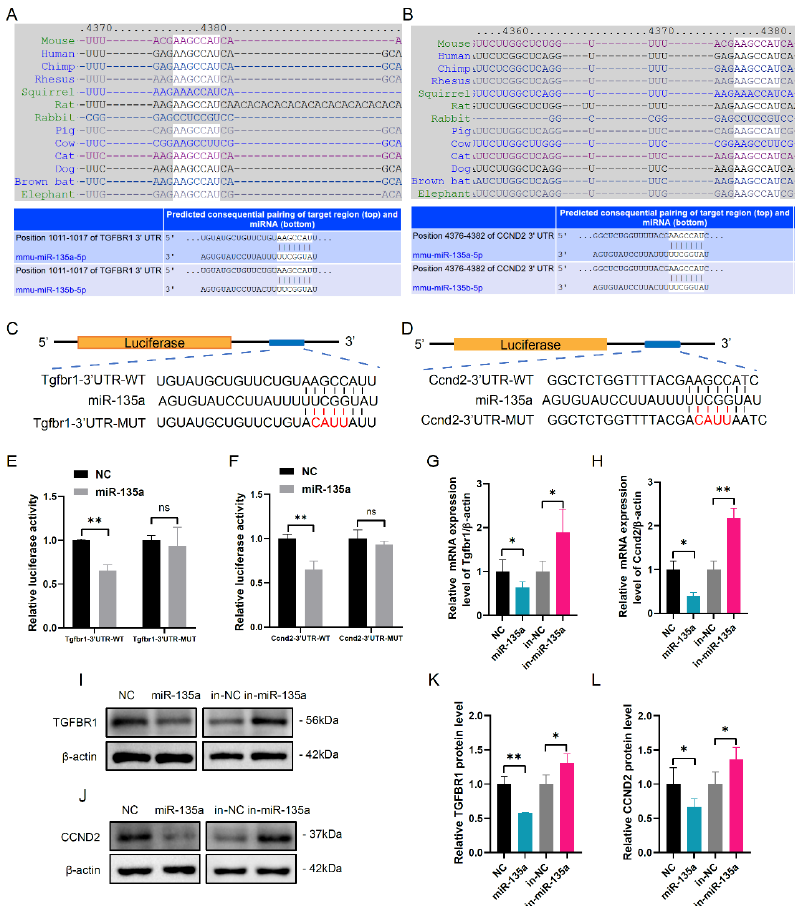
Figure 2. Tgfbr1 and Ccnd2 are the targets of miR-135a. Targetscan software showed the predicted miR-135a binding site in ( A ) Tgfbr1 and ( B ) Ccnd2 3 ′ UTRs. The wild type (WT) and mutational (MUT) 3 ′ UTRs of ( C ) Tgfbr1 and ( D ) Ccnd2 mRNAs were shown in mGCs. The mutant bases in the 3’